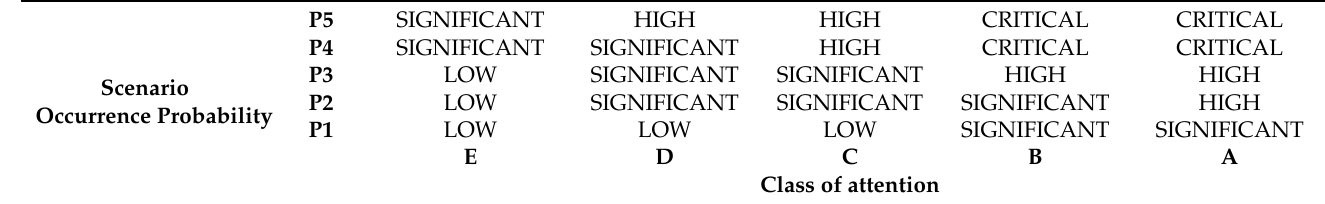
Table 5. Risk decision matrix for “IF-THEN-ELSE” rules